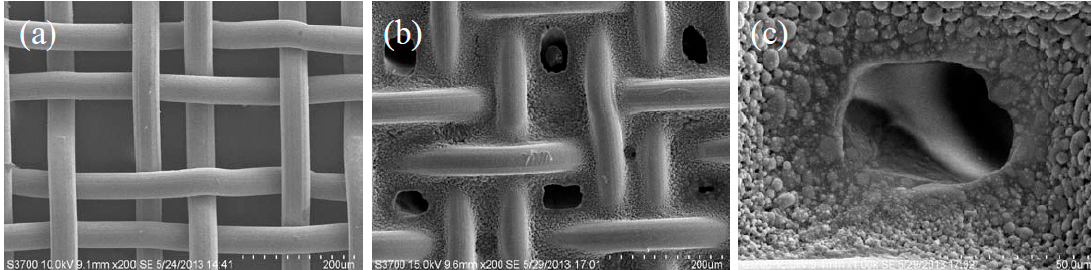
Figure 8. SEM images of the hybrid-coated mesh film prepared using stainless steel mesh with an average pore diameter of about 50 mm. ( a ) Large-area view of the stainless steel mesh, ( b ) large-area view of the hybrid -coated mesh film, and ( c ) enlarged view of the hybrid-coated mesh film.